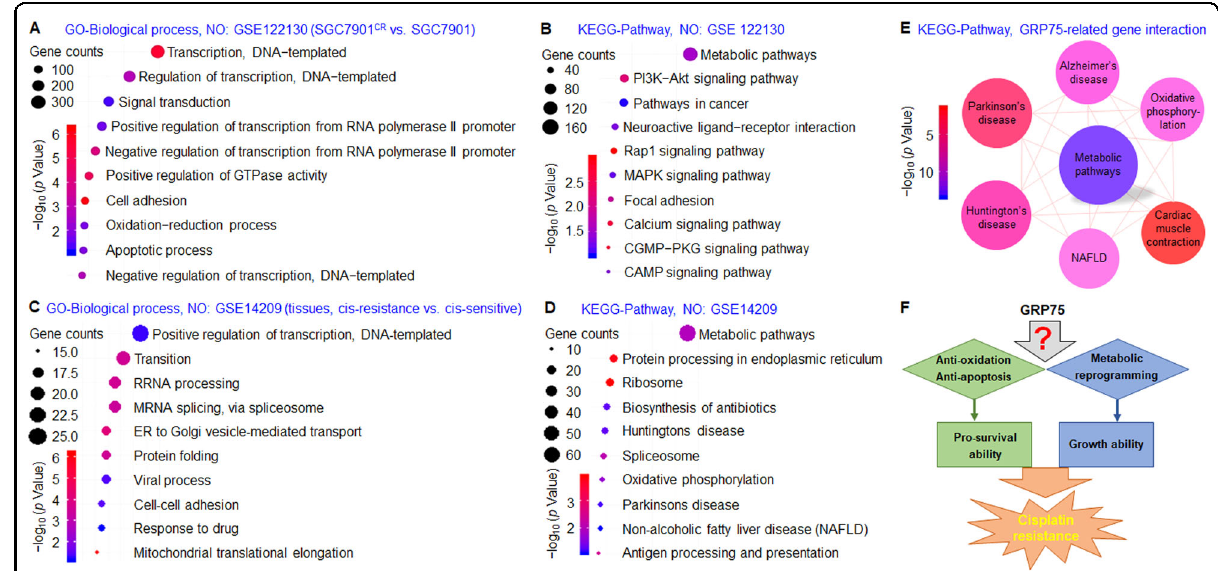
Fig. 2 Potential mechanisms underlying GRP75 caused cisplatin-resistance. A and B GO-Biological process and KEGG-pathway analyses of DEGs from the GSE122130 dataset. C and D GO-Biological process and KEGG-pathway analysis of DEGs from the GSE14209 dataset. E Network-Analyst was used to analyze the PPI network of GRP75 and its interactors according to the KEGG database. F A hypothetic scheme showed that GRP75 might promote survival and growth of GC which leading to cisplatin-resistance via anti-oxidation/apoptosis and metabolic reprogramming, but the mechanism was